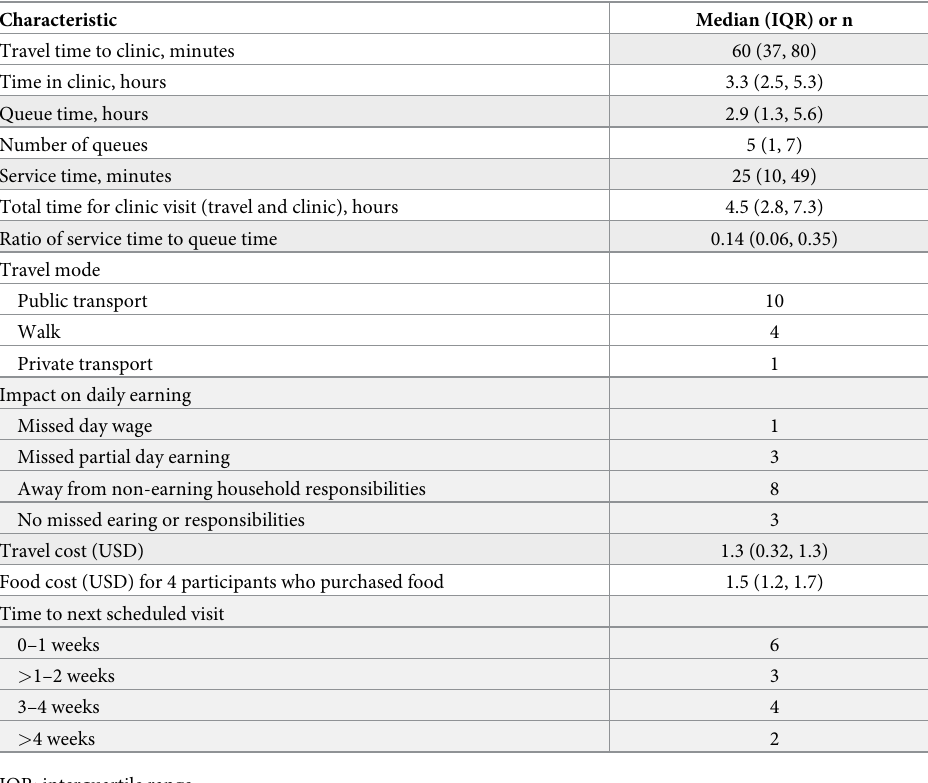
Table 1. Value stream mapping